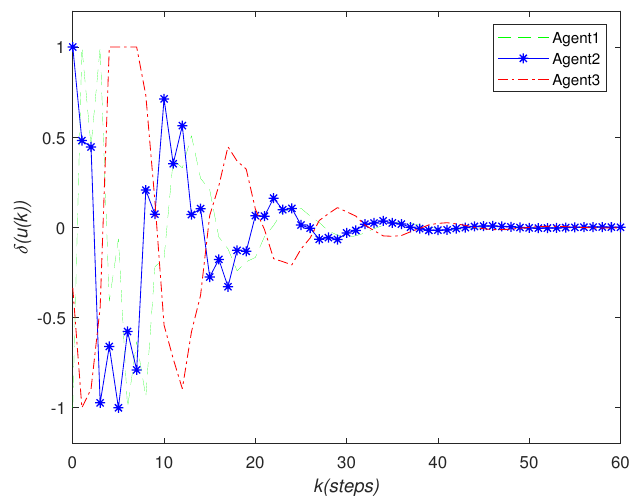
Figure 7. Saturation input